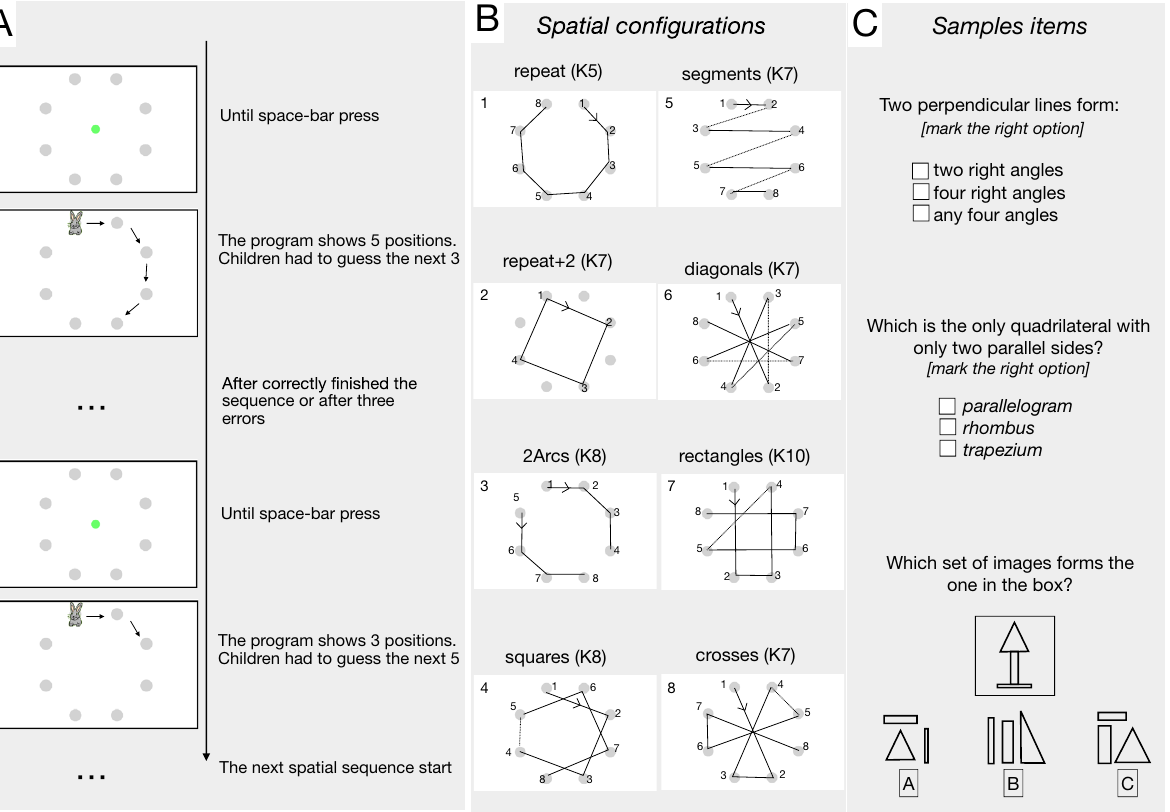
Figure 1. Non-symbolic and formal geometry tasks. ( A ) Schematic representation of the procedure to assess non-symbolic geometry (the “repeat” spatial sequence is depicted). ( B ) Representation of the eight spatial configurations tested. The numbers near the circles represent the order followed by the flashing stimulus. The numbers in the boxes represent the presentation order. Complexity (K) is indicated for each sequence. ( C ) Three examples of items measuring formal geometrical abilities (reproduced with